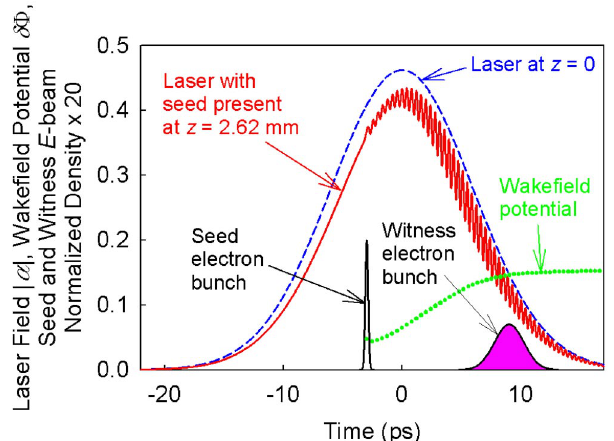
FIG. 2. (Color) Model prediction for laser field parameter j a (cid:5) r (cid:1) 0 (cid:6)j and wakefield potential (cid:7) (cid:1) ( r (cid:1) 0 ) as a function of FIG. 1. (Color) Model prediction for the maximum of laser field time for z (cid:1) 2 : 62 mm and t and wakefield potential (cid:7) (cid:1) ( r (cid:1) parameter j a (cid:5) r (cid:1) 0 ; z (cid:6)j seed and witness e -beam bunch positions for (cid:1) max max (cid:1) 2 : 97 ps . j a (cid:5) r (cid:1) 0 ; z (cid:1) 0 (cid:6)j 0 ; z ) as a function of distance along the plasma for t d